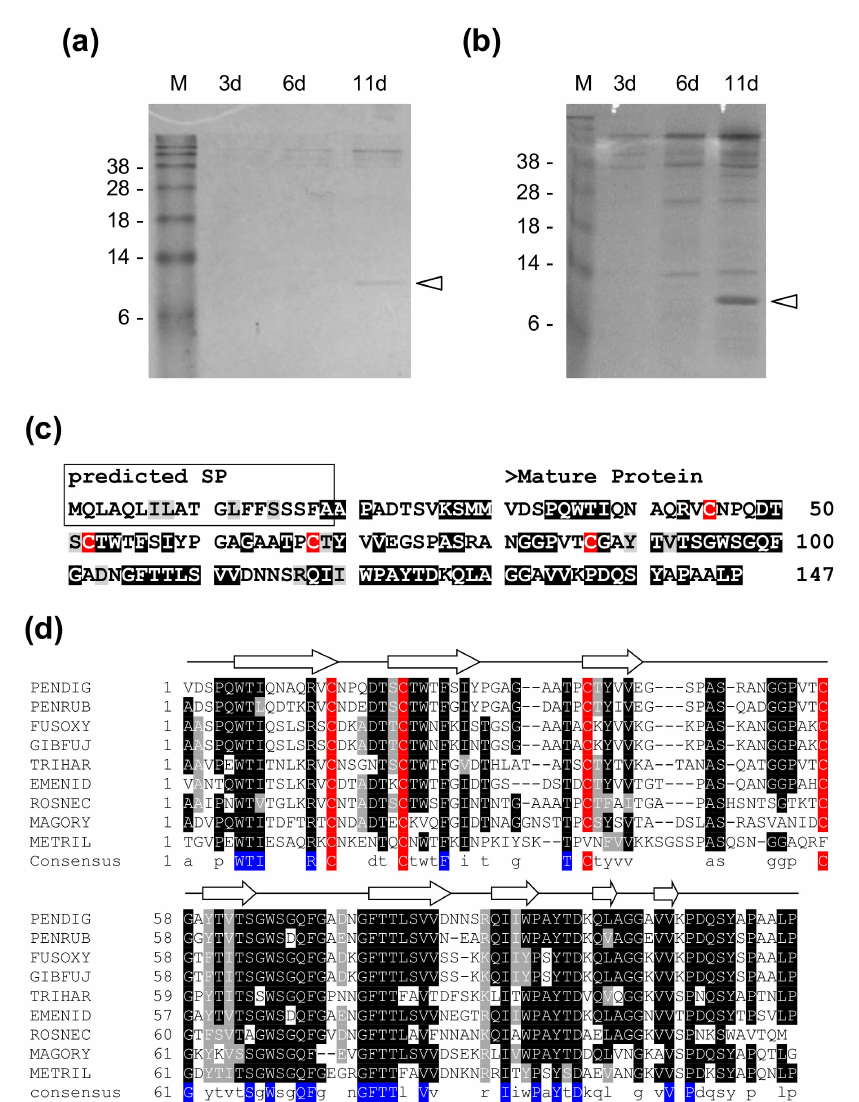
Figure 1. Production and identification of the Secreted Cysteine-rich Anionic (Sca) protein from P. digitatum CECT 20796 strain. ( a ) SDS-PAGE of non-concentrated supernatants of P. digitatum grown in potato dextrose broth (PDB) for 3, 6 and 11 days. Sca is marked by an arrow. ( b ) SDS-PAGE of the same supernatants 10 × concentrated. M: SeeBlue ® pre-stained protein standard. ( c ) Amino acid sequence of the Sca protein. Predicted signal peptide (SP, framed) and small pro-sequence are absent in the mature protein. Highly conserved and conserved amino acids are shadowed in black and in gray, respectively, and are concluded from the alignment in Supplementary Figure S2. ( d ) Amino acid sequence alignment of chosen Sca homologs from di ff erent filamentous fungi. Arrows represent predicted secondary structural elements of Sca from P. digitatum . Conserved cysteine residues are shadowed in red. Extremely conserved amino acids are shadowed in blue in the consensus sequence. Highly conserved amino acids are shadowed in black and conserved amino acids are shadowed in gray. Abbreviations: PENDIG, Penicillium digitatum ; PENRUB: Penicillium rubens ; FUSOXY, Fusarium oxysporum ; GIBFUJ, Gibberella fujikuroi ; TRIHAR, Trichoderma harzianum ; EMENID, Emericella nidulans ; ROSNEC, Rosellinia necatrix ; MAGORY, Magnaporthe oryzae ; METRIL, Metarhizium rileyi . An extended version of this alignment can be seen in Supplementary Figure